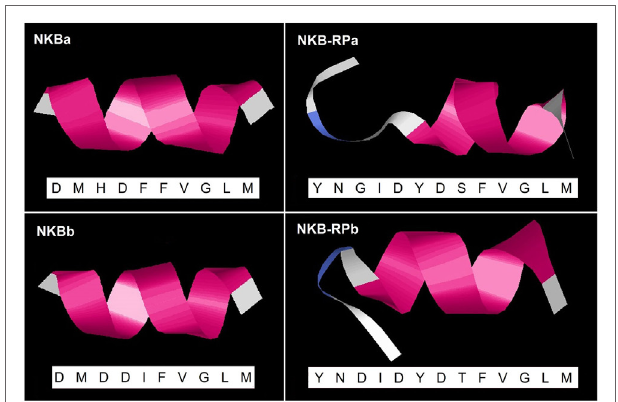
FigUre 6 | Predicted 3D structure of eel TAC3 peptides. The amino acid sequences of eel NKBa, NKB-RPa, NKBb, and NKB-RPb are indicated. Eel NKBa has the same sequence as human neurokinin B (NKB). Models predicted in I-TASSER server with a C -score between 2 and − 5 were presented. The C-terminal is oriented toward the right. In pink appears α -helix, in blue turn, and in white random